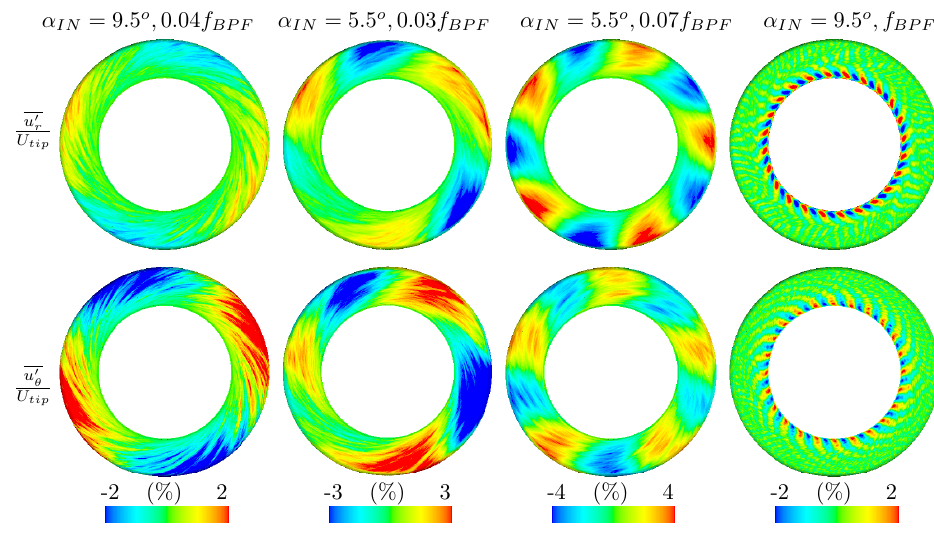
Figure 8. Fourier surface spectra flow mode decomposition. Narrowband radial (top row) and tangential (bottom row) velocity fluctuation intensity colored on a midway-section between hub and shroud which follows the diffuser curvature. In detail, this correspond to n = 0.5, [ 0,2 π ] . In the figure this is presented in a frontal view, which means that points for meridional θ ∀ ∈ positions at the top of the domain and beyond towards the outlet are not seen. Rotating stall modes at different flow angles, α IN = 9.5 ◦ (first column) and α IN = 5.5 ◦ (second and third columns). Last column shows the blade passing frequency flow mode for α IN = 9.5 ◦